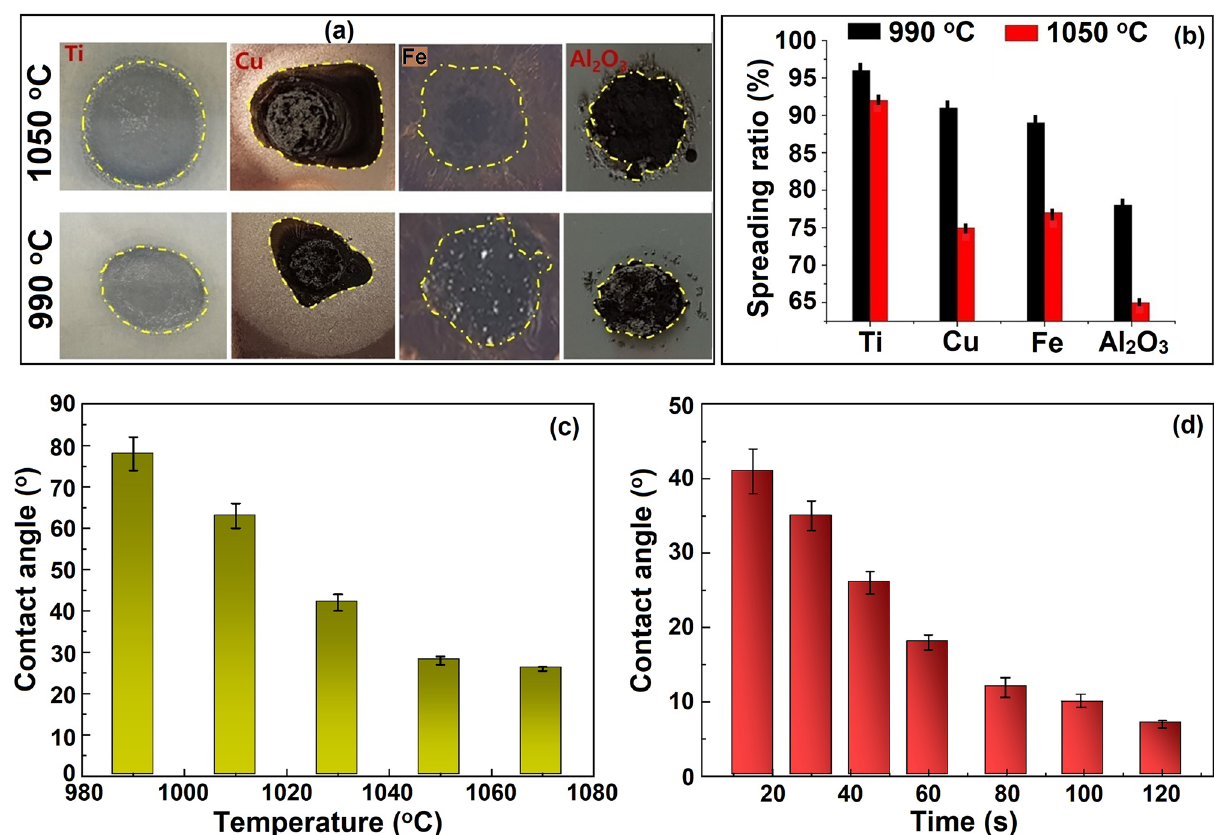
Figure 5. ( a ) Spread ratio images at different temperatures and substrates; ( b ) calculated spread ratio; ( c , d ) contact angles measured at different temperatures and times on